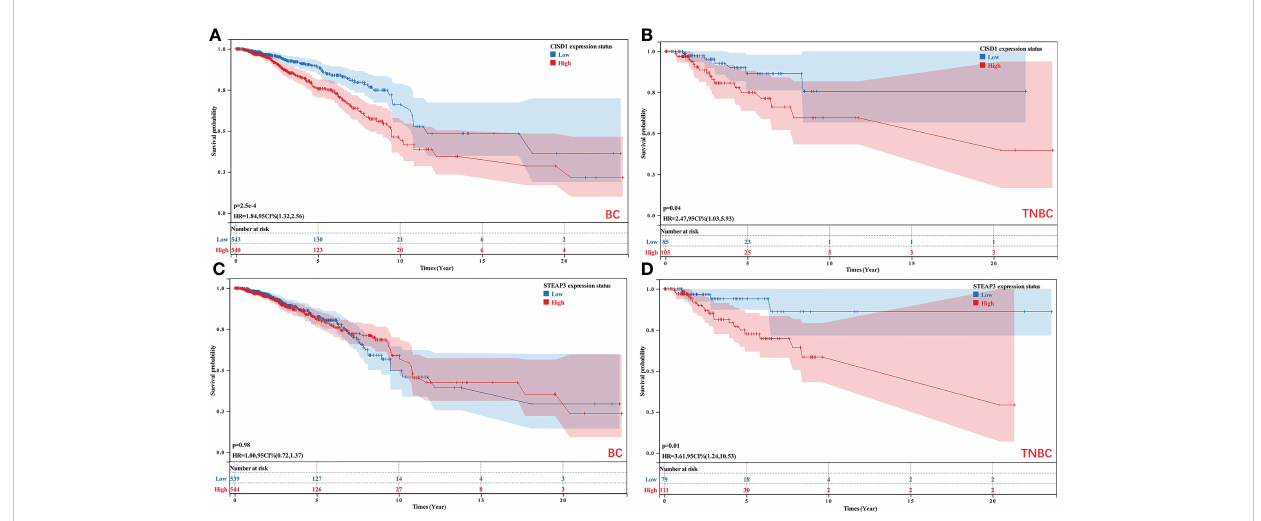
FIGURE 6 Analyses of the relationship between CISD1 and STEAP3 expression and the survival of BRCA and TNBC patients. (A, B) The relationship between the expression of CISD1 and the OS of BC ( P <0.05) and TNBC patients ( P <0.05). (C, D) The relationship between the expression of STEAP3 and the OS of BC ( P >0.05) and TNBC patients ( P <0.05).